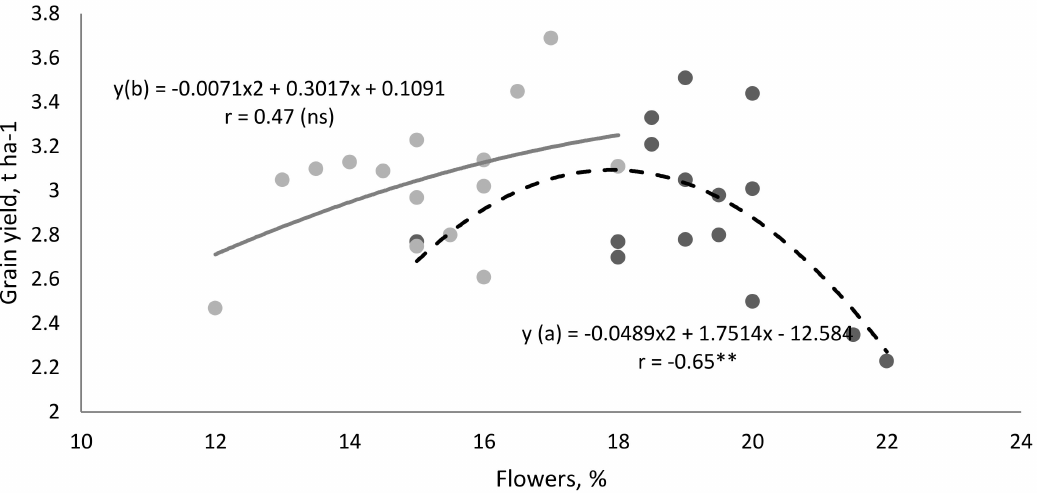
Figure 5. Correlation between morphostructural elements of buckwheat plants and grain yield: a—organic farming system, b—conventional farming system (**—Significant values with p < 0.01; ns—not